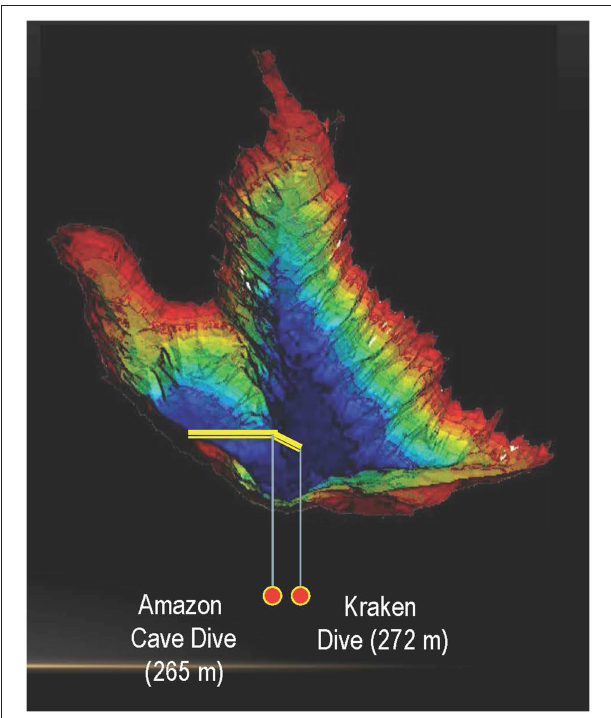
FIGURE 3 | Bathymetric map of Laguna Negra showing locations of the deepest samplings and video points at Amazon Cave Dive (262m) and Kraken Dive (272m).